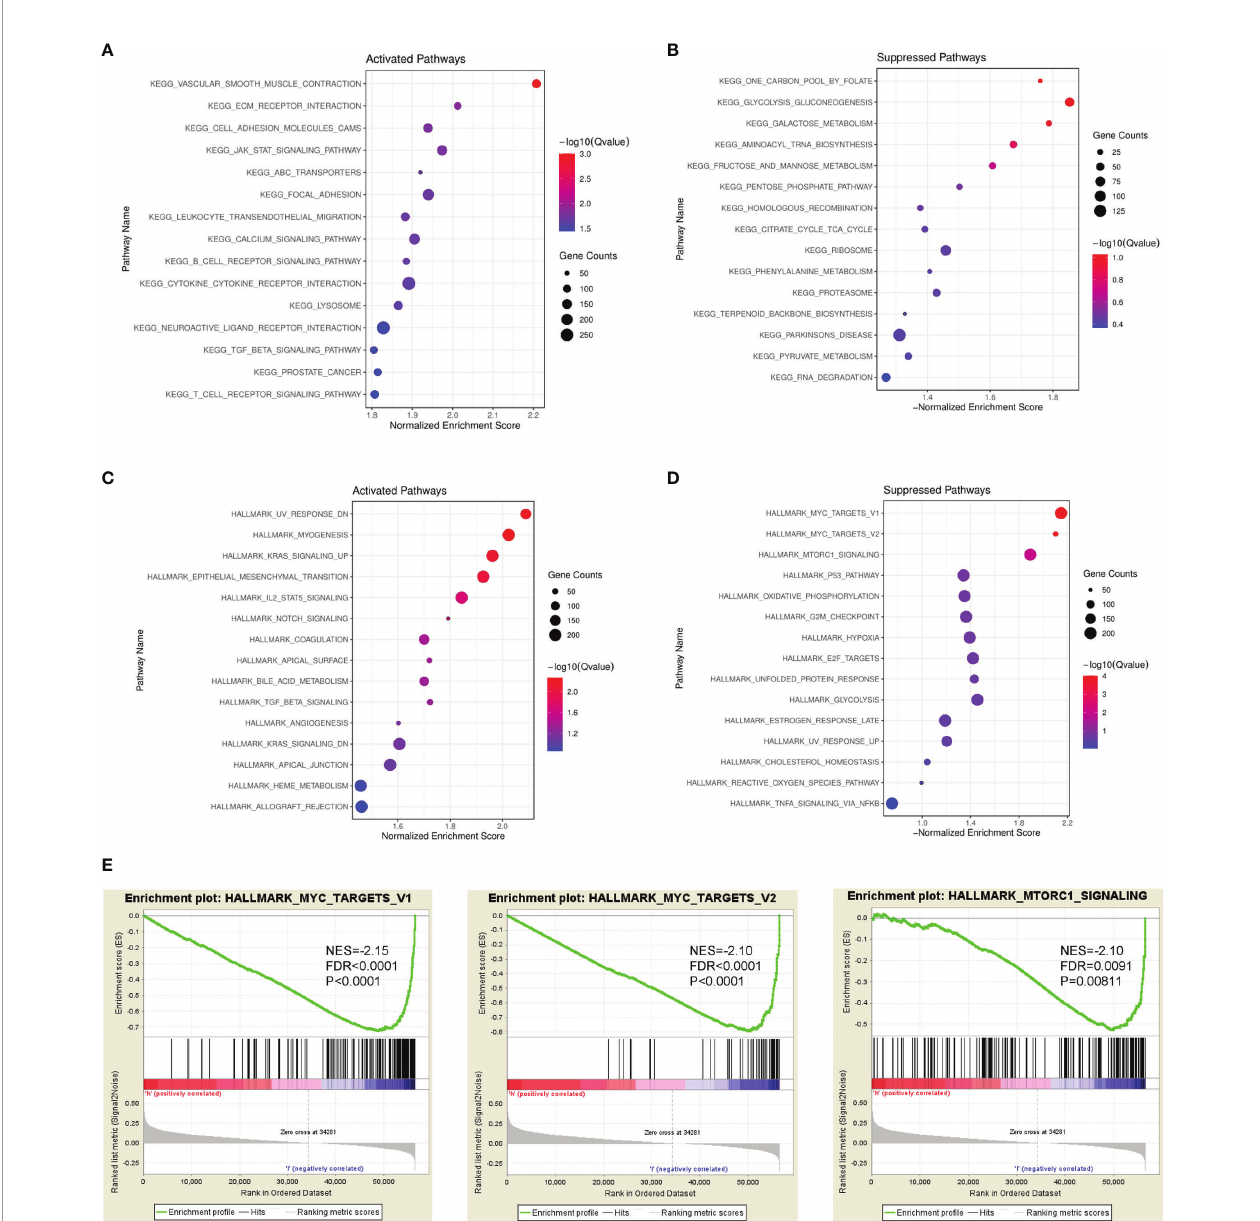
FIGURE 4 | GSEA identi fi ed PAMR1-related signaling pathways. Bubble diagram of the top 15 KEGG pathways enriched by high expression (A) or low expression (B) of PAMR1 in TCGA-CESC data. Bubble diagram of the top 15 Hallmark pathways enriched by high expression (C) or low expression (D) of PAMR1 in TCGA- CESC data. (E) Gene set enrichment plots of the MYC target signaling pathway and mTORC1 signaling pathway in TCGA-CESC data with low PAMR1